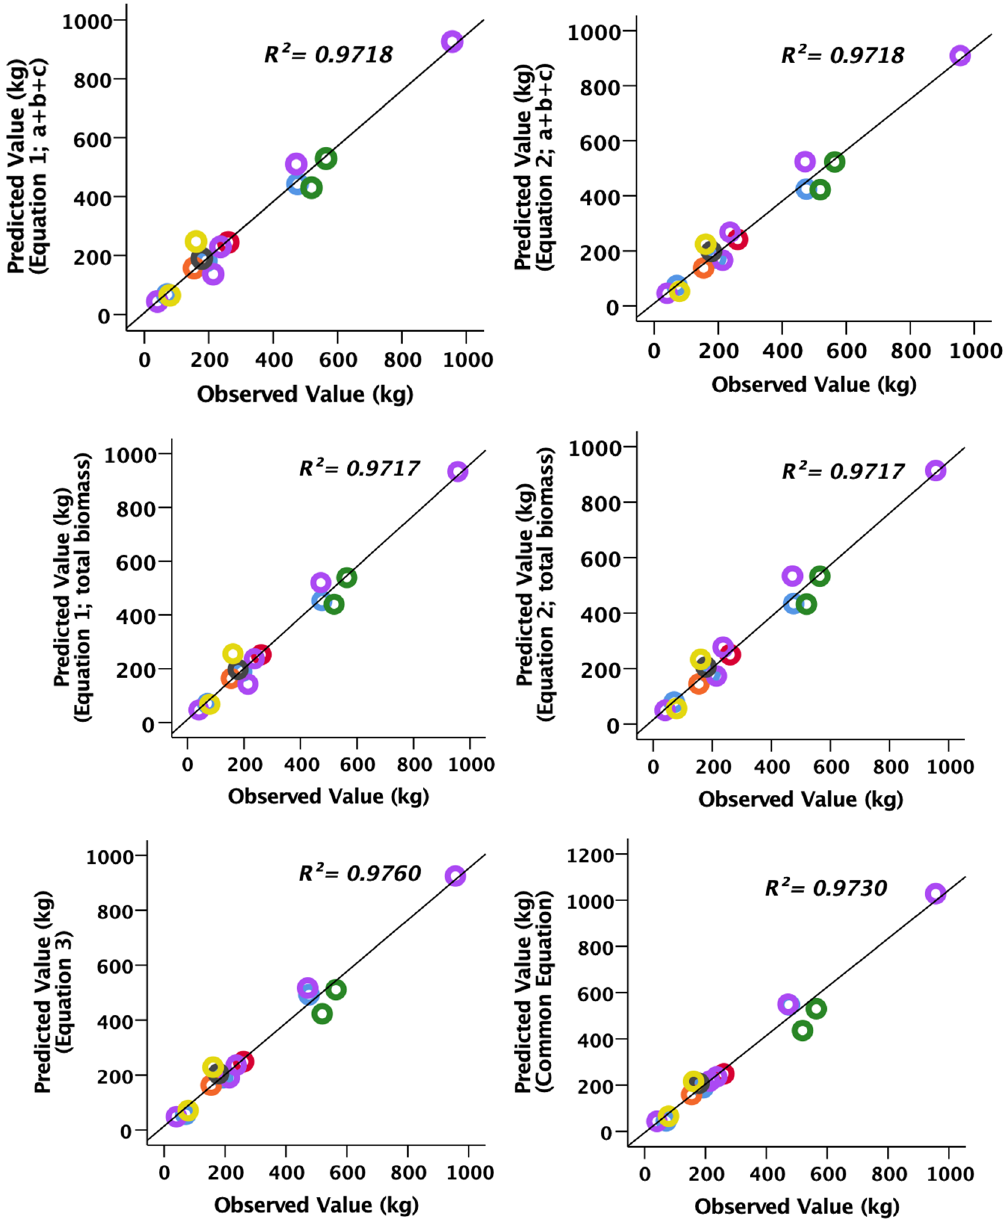
Figure 3. Comparison of the observed value and predicted value of aboveground biomass (kg) for a single variable (D) and incorporated variables (D 2 H, and D and ρ variables) of 15 destructive trees. Blue: Bruguiera cylindrica (L.) Blume, red: Bruguiera parviflora (R.) Wight; green: Bruguiera sexangula (L.) Poir; orange: Ceriops tagal (P.) Rob; purple: Rhizophora apiculata (L.) Blume; dark grey: Rhizophora mucronata (L.) Lam; and yellow: Xylocarpus granatum (J.) Koenig .